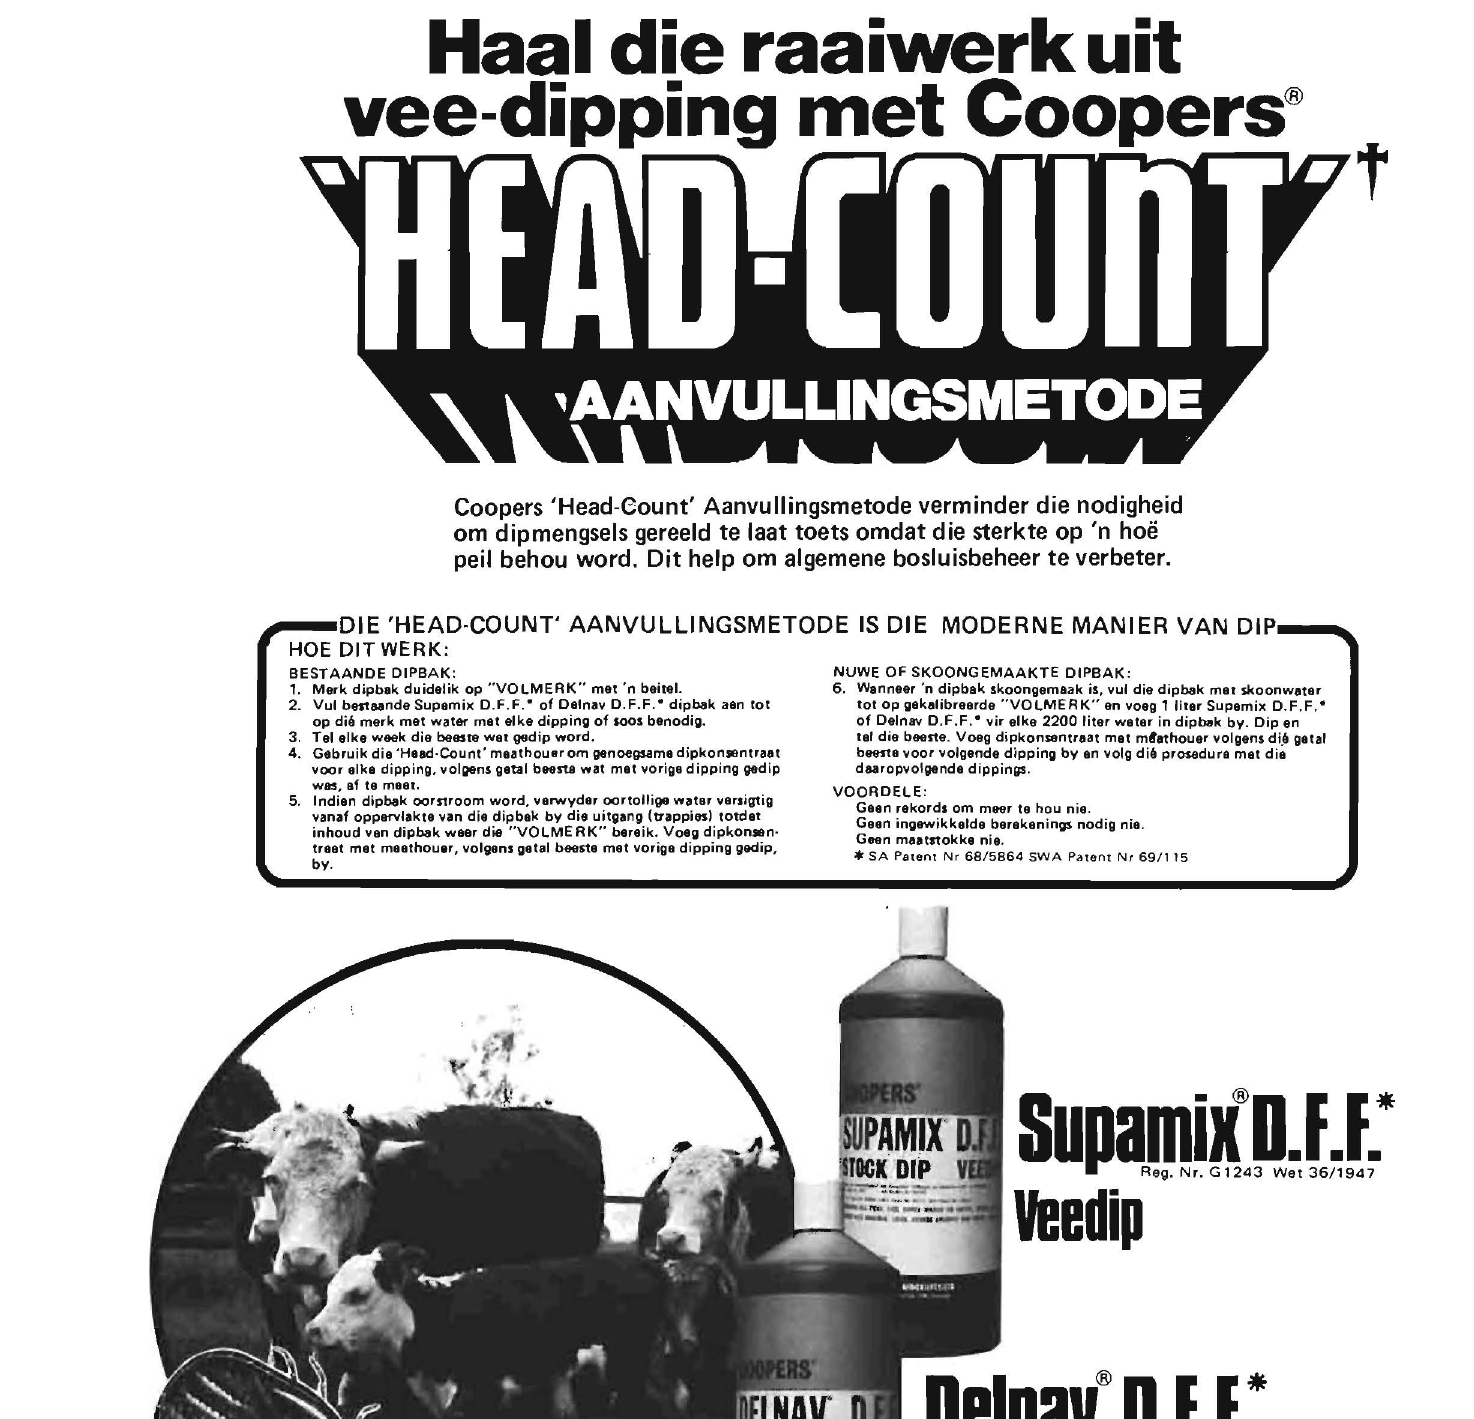
Delnav® D.f .f.* Reg. Nr. G1245 We. 36/1947 Beesdip Vra u Coopers verteenwoordiger of skryf direk aan Coopers as u verdere inligting verlang. ® COOPERS -nimmereindigende verdedigingsirkel In.erne.lonal